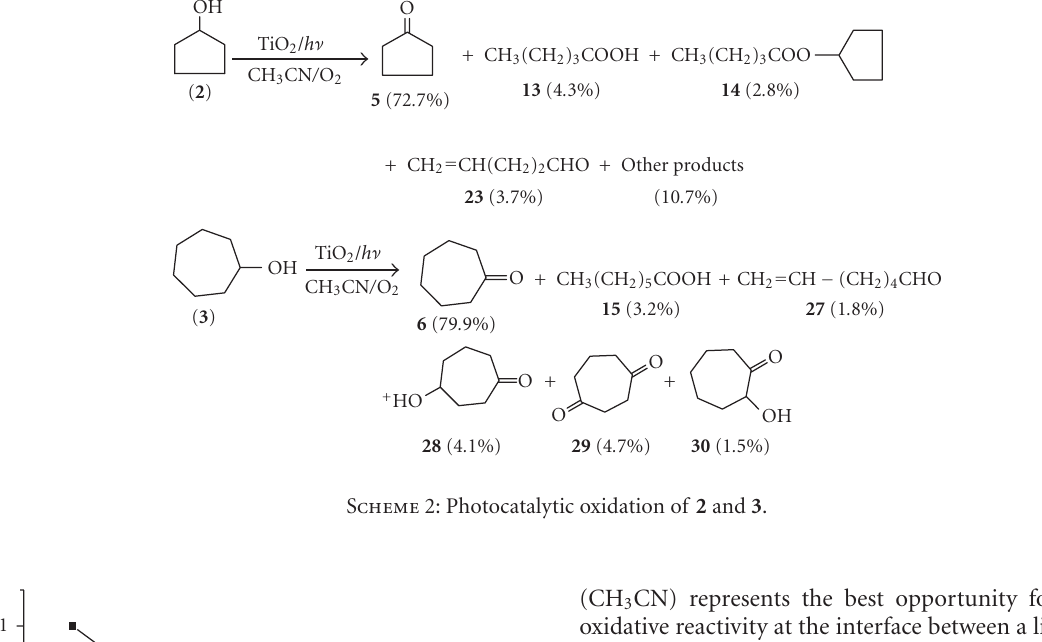
Scheme 2: Photocatalytic oxidation of 2 and 3 .